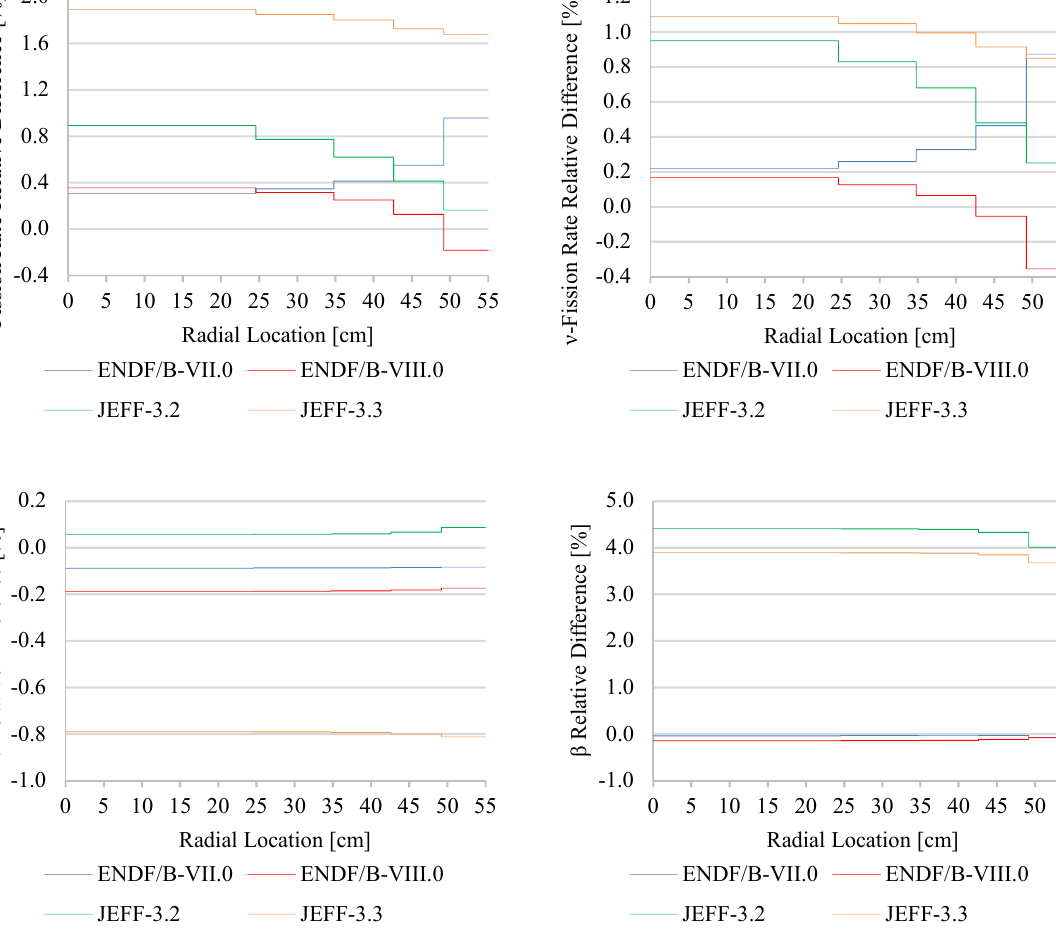
Figure 7. Radial Nuclear Data Library Differences from ENDF/B-VII.1 in One-Group Fission Rate, ν-Fission Rate, ν, and β Using Simplified Cylindrical